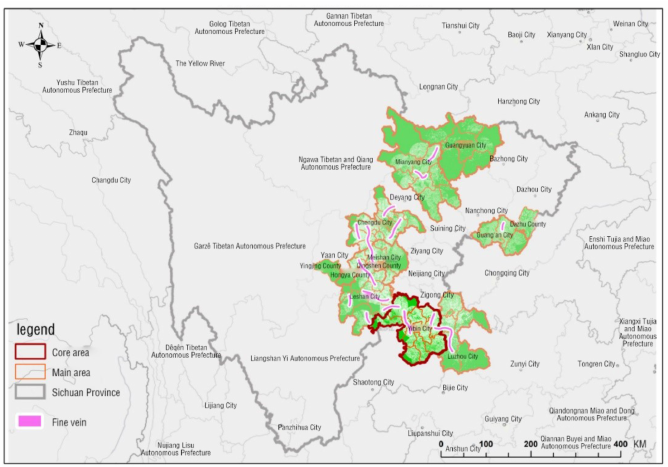
Figure 27. Distribution of fine veins of research areas in Sichuan Province.